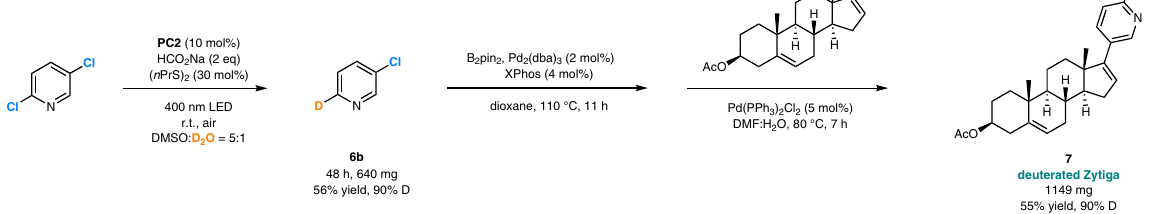
reactions of symmetric dichlorinated pyridine derivatives ( 5a − 5d ) only afforded monodeuterated compounds ( 6a − 6d ) in 61 ‒ 92% yield and with 90 ‒ 98% D-inc. Prolonged reaction time did not lead to the formation of dideuterated products. Excellent site- selectivity could be observed for a number of unsymmetric (hetero)aryl chlorides, all of which provided monodeuterated products ( 6e – 6o ) with high deuterium incorporation (78 ‒ 97%). Typically, a C-Cl bond at α -positions next to the nitrogen atom in NATURE COMMUNICATIONS| (2021) 12:2894